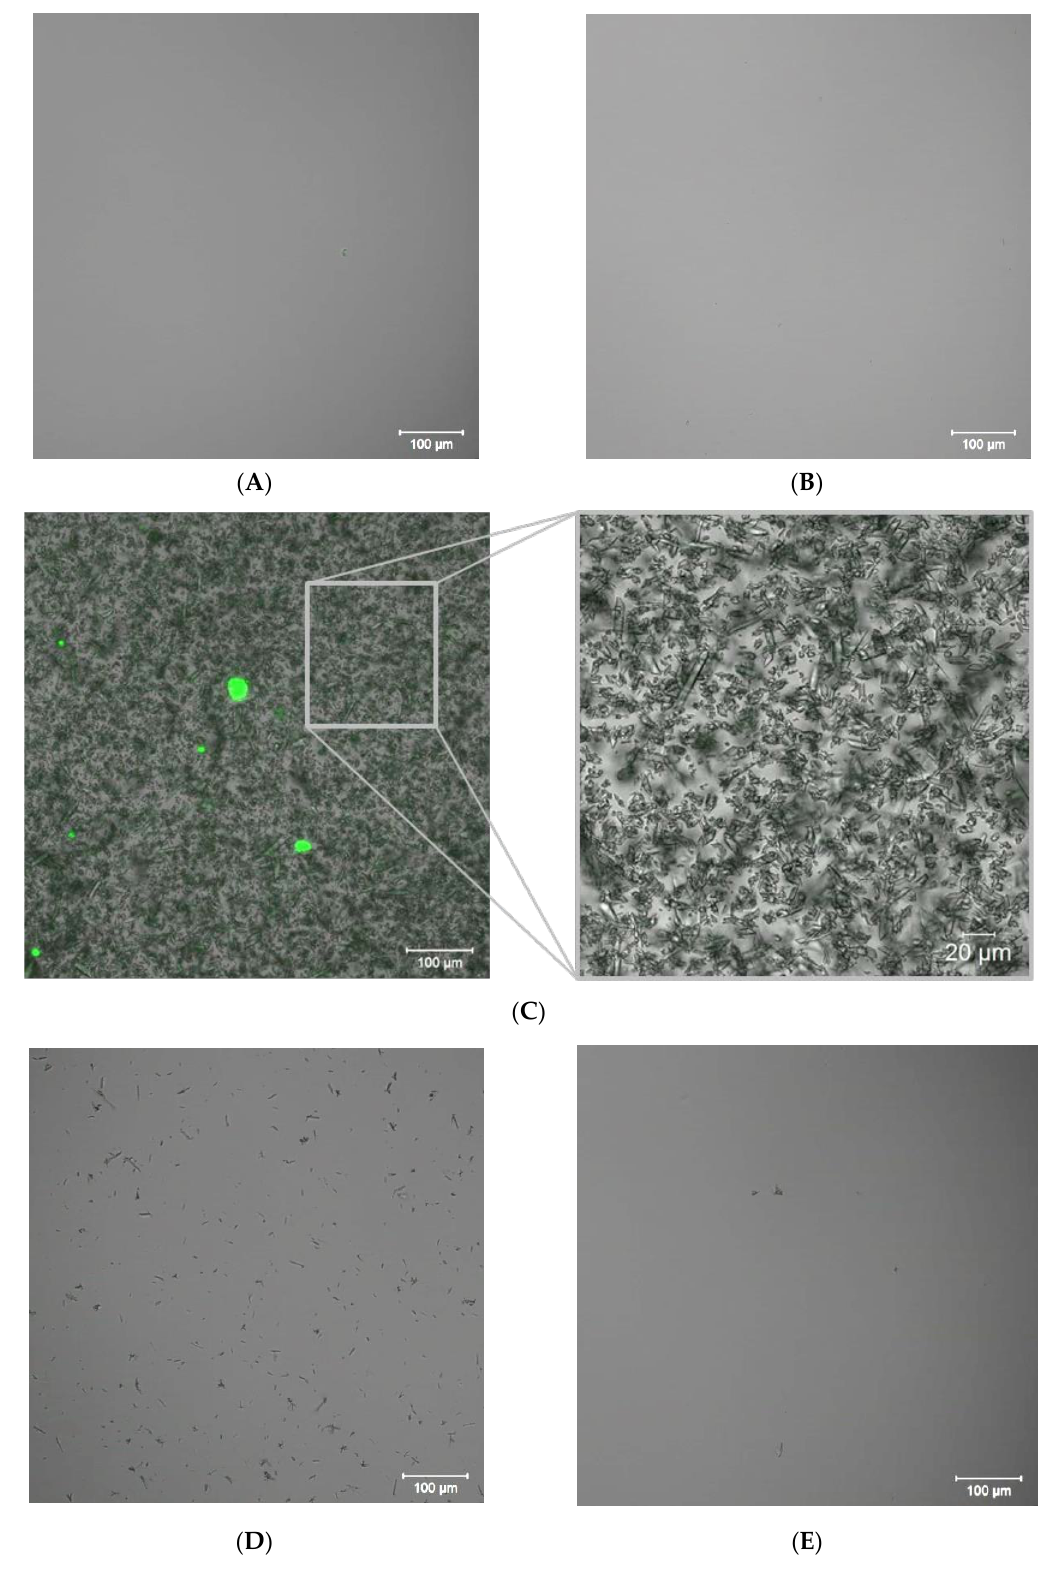
Figure 8. Fluorescent images of initial undersaturated gypsum solution droplets ( A ), K = 1, and of retentate at K = 2 ( B ), K = 3 ( C ), K = 4 ( D ), K = 5 ( E ) within the GSI experiment.